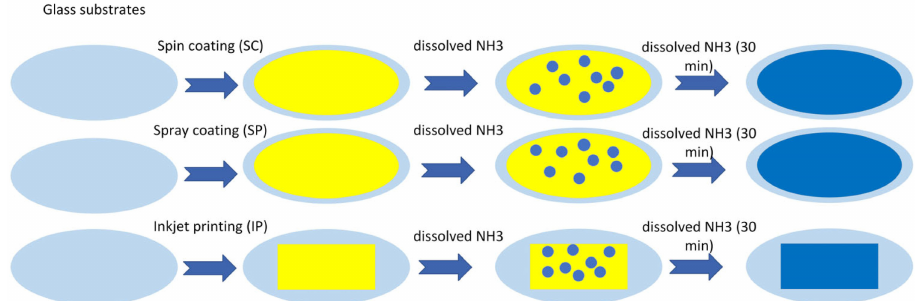
Figure 1. Schematic representation of the response of the optical sensors to NH 3